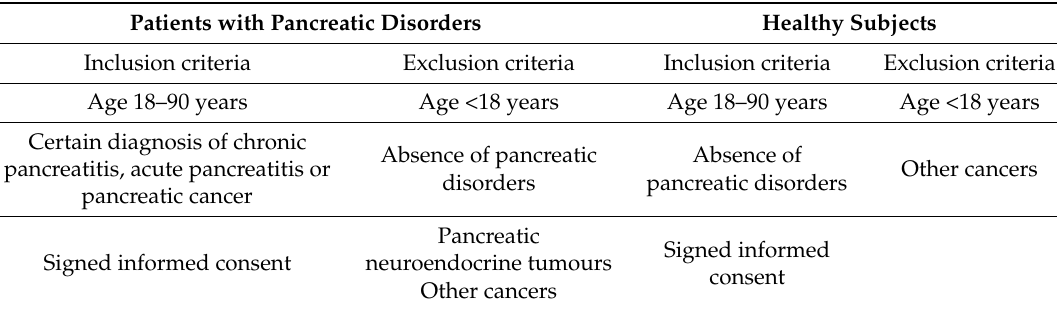
Table 4. Inclusion and exclusion criteria for the